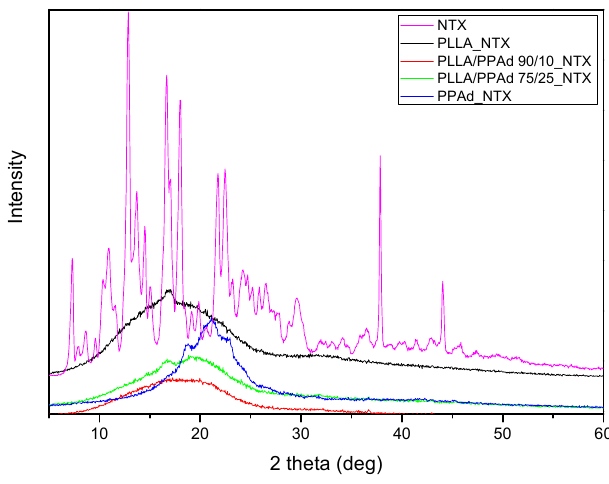
Figure 12. X-ray diffraction (XRD) patterns of neat naltrexone and prepared naltrexone microspheres with PLLA, PPAd, and PLLA-b-PPAd 90/10 and 75/25 w/w copolymers.